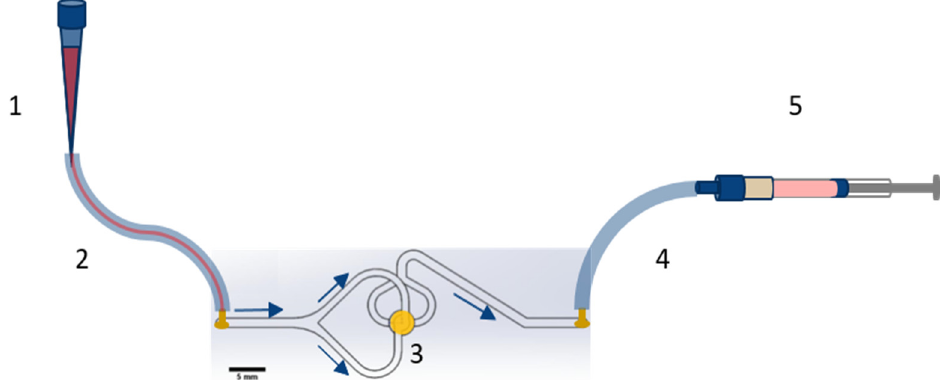
Figure 3. Scheme of the filtration setup with its components. The syringe was operated by a syringe pump. To operate the filtration setup, the cell containing sample was filled into the pipette tip, serving as inlet funnel (1) connected to the set-up via silicone tubes (2 and 4), and drawn over the filter (3) into the syringe (5) operated by a syringe pump (not shown in the image) with a defined flow rate profile. The cells captured on the TEM-grid were detected by fluorescence microscopy at 50-fold magnification.